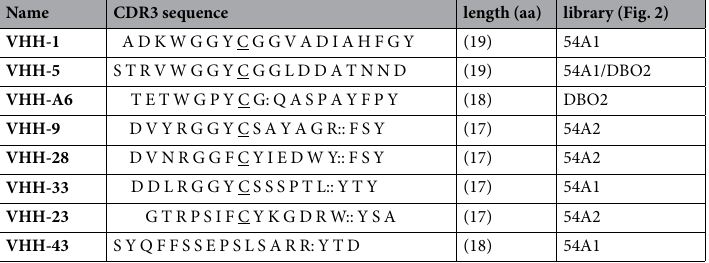
Table 2. CDR3 sequences of selected nanobodies. Sequences were aligned by eye. The conserved cysteine forming a disulfide with a cysteine in CDR1 is underlined; “:” indicates deleted amino